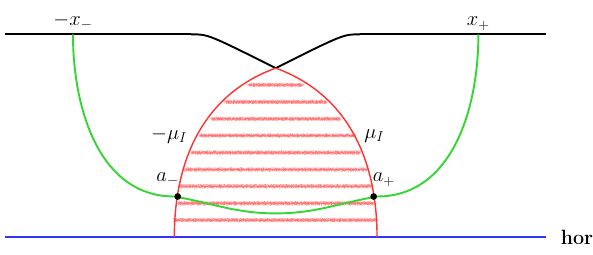
Figure 9 . In this (cid:12)gure, we depict an o(cid:11)-shell con(cid:12)guration where one connects ( x + ; t ) to ( a + ; t ), ( a + ; t ) to ( a (cid:0) ; t ), and ( a (cid:0) ; t ) to ( contribution is non-dynamical and shared by Grav theories are not completely decoupled from each